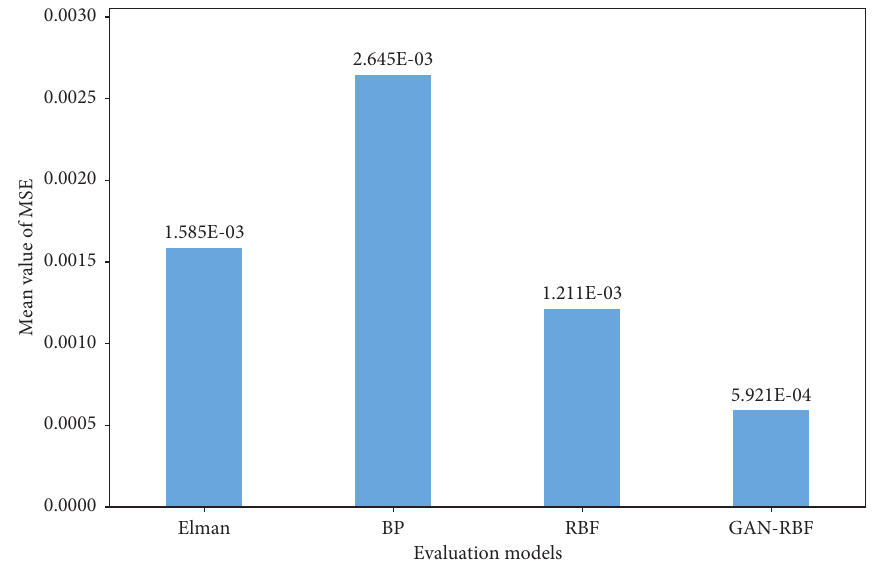
Figure 6: Comparison of MSE mean value.